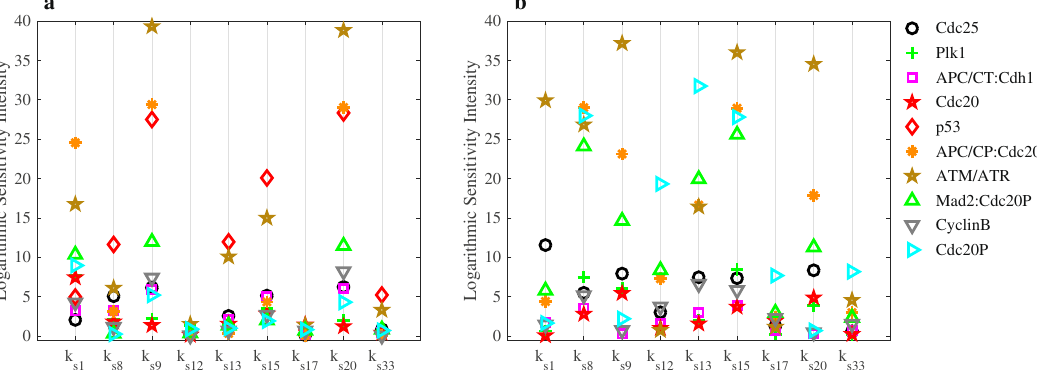
Fig. 6 Logarithmic intensities for Cdc25, Plk1, APC/CT:Cdh1, Cdc20, ATM/ATR, Mad2:Cdc20P, p53, APC/CP:Cdc20, Cyclin B, and Cdc20P regulators. a p53-wild-type cancer cells. b p53-null cancer cells under the Plk1-depletion condition (Plk1 is depleted by 45% relative to Plk1 level in wild-type cells). The sensitivity intensities are obtained by varying k s1 , k s8 , k s9 , k s12 , k s13 , k s15 , k s17 , k s20 , and k s33 parameters that control the synthesis rates of Cyclin B, Cdc25, Wee1, Plk1, PP2A, APC/C, Cdc20, Cdh1, and Mad2, correspondingly.